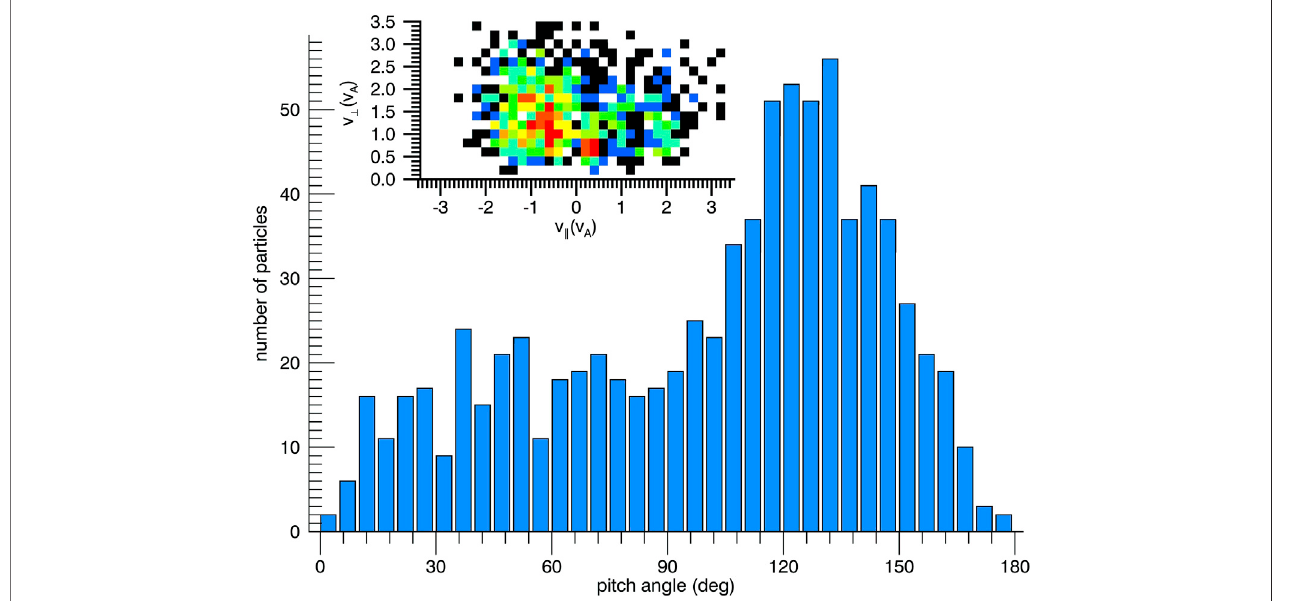
FIGURE 9 | Pitch angle distribution of energetic particles in the sheath from hybrid